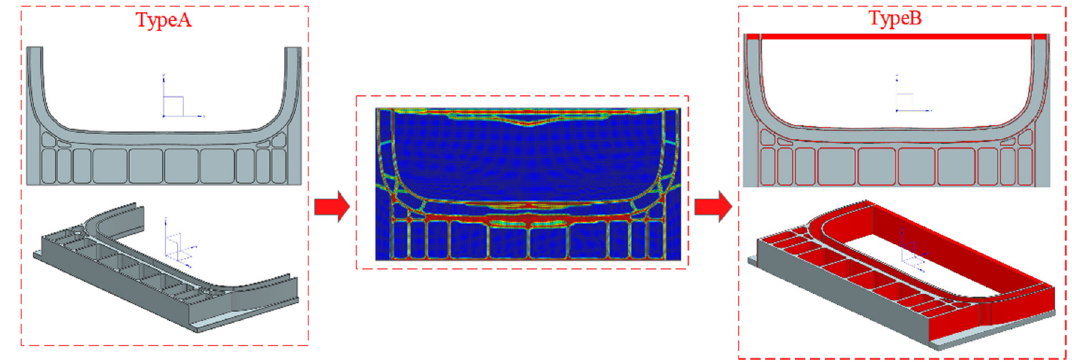
Figure 3: Iterative process of topology optimization.